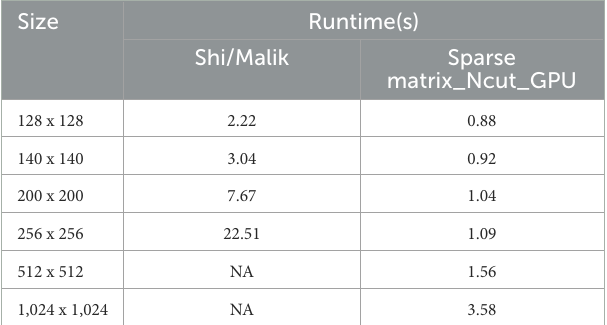
TABLE 4 The demonstration of speed time to calculate image segmentations between Shi/Malik method and our method by